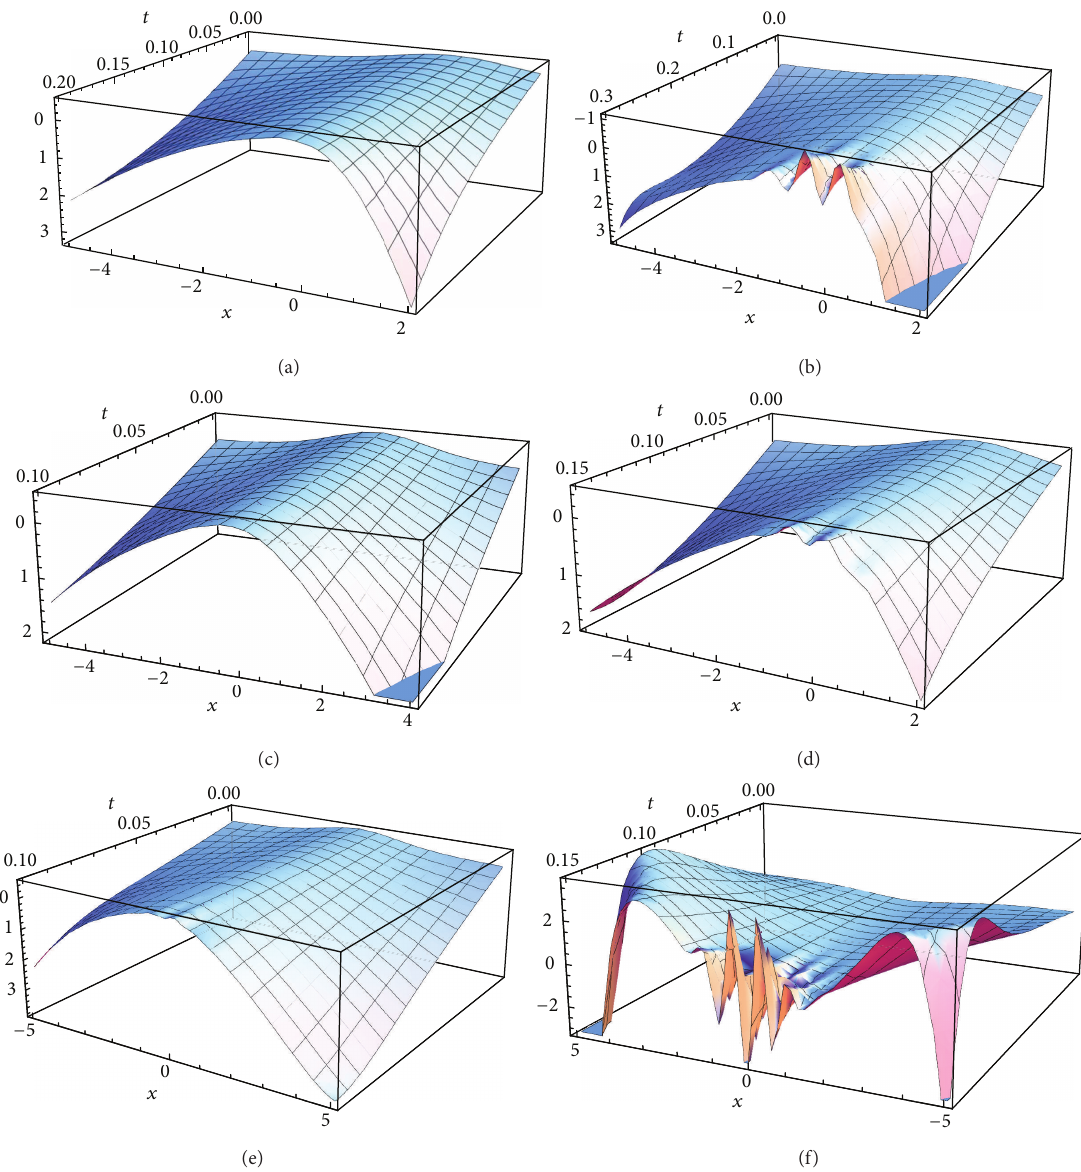
Figure 3: The HAM solution at 10th-order approximation with different convergence values of ℎ . (a and b) for ℎ = −0.6 , (c and d) for ℎ = −1.0 , and (e and f) for ℎ = −1.4 .